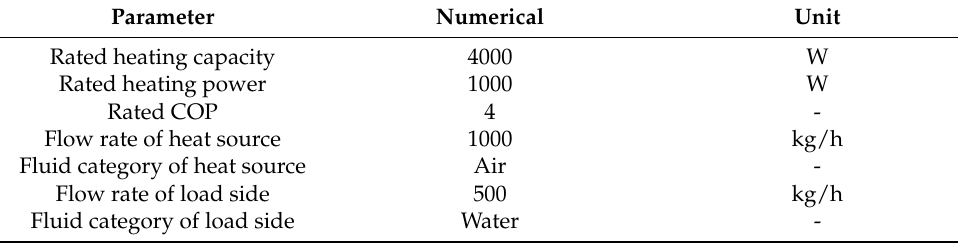
Table 4. Parameter of AHP. Parameter Numerical